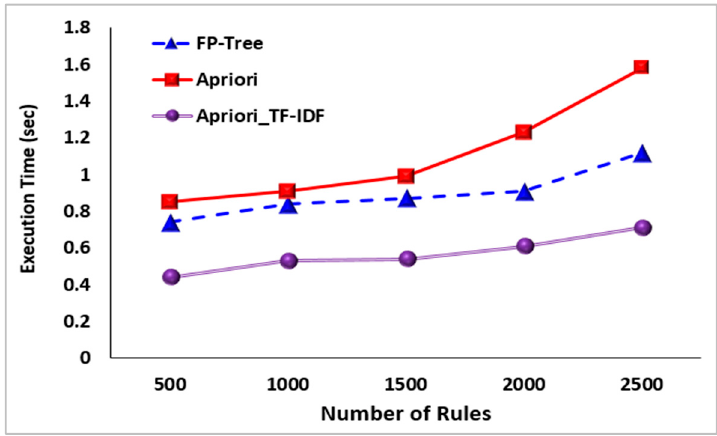
Figure 13. Rule Generation Speed Comparison of FP-Tree, Apriori, Apriori_TF-IDF Algorithm.